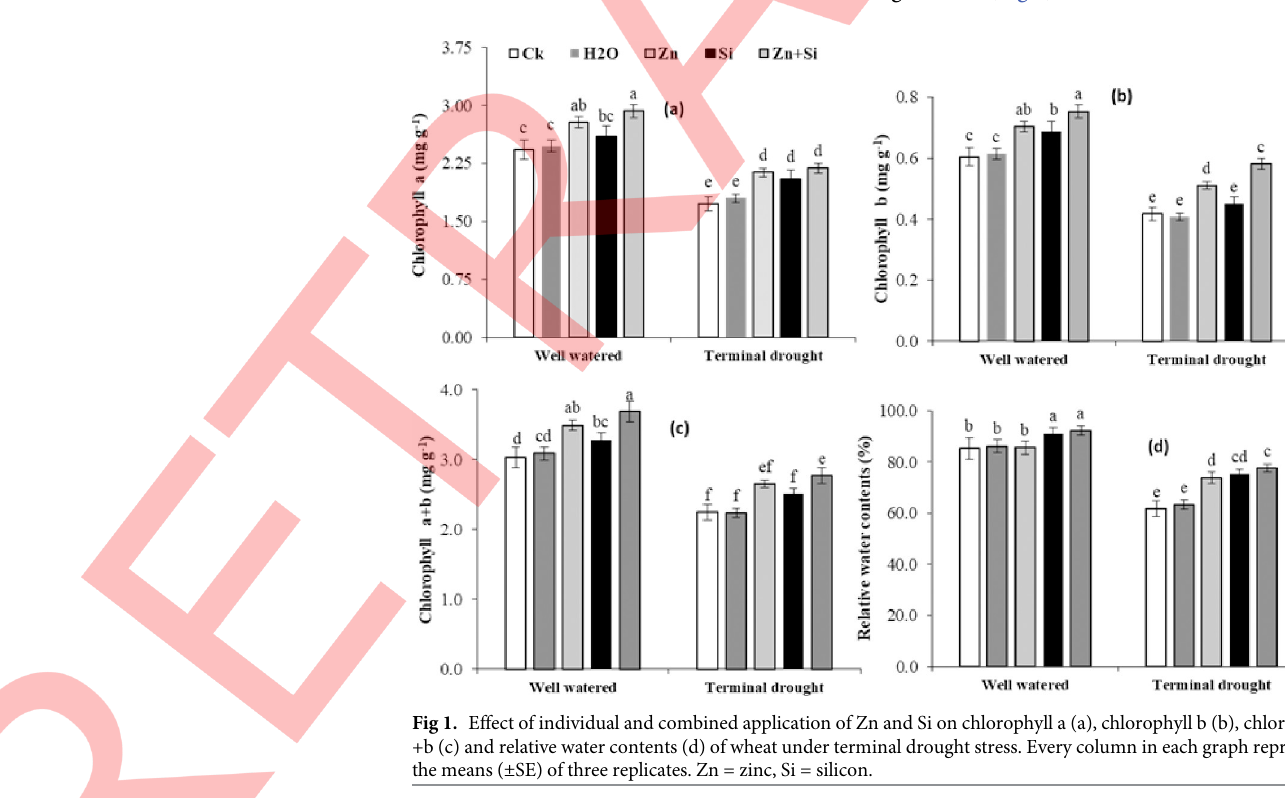
Fig 1. Effect of individual and combined application of Zn and Si on chlorophyll a (a), chlorophyll b (b), chlorophyll a +b (c) and relative water contents (d) of wheat under terminal drought stress. Every column in each graph represents the means ( ± SE) of three replicates. Zn = zinc, Si =